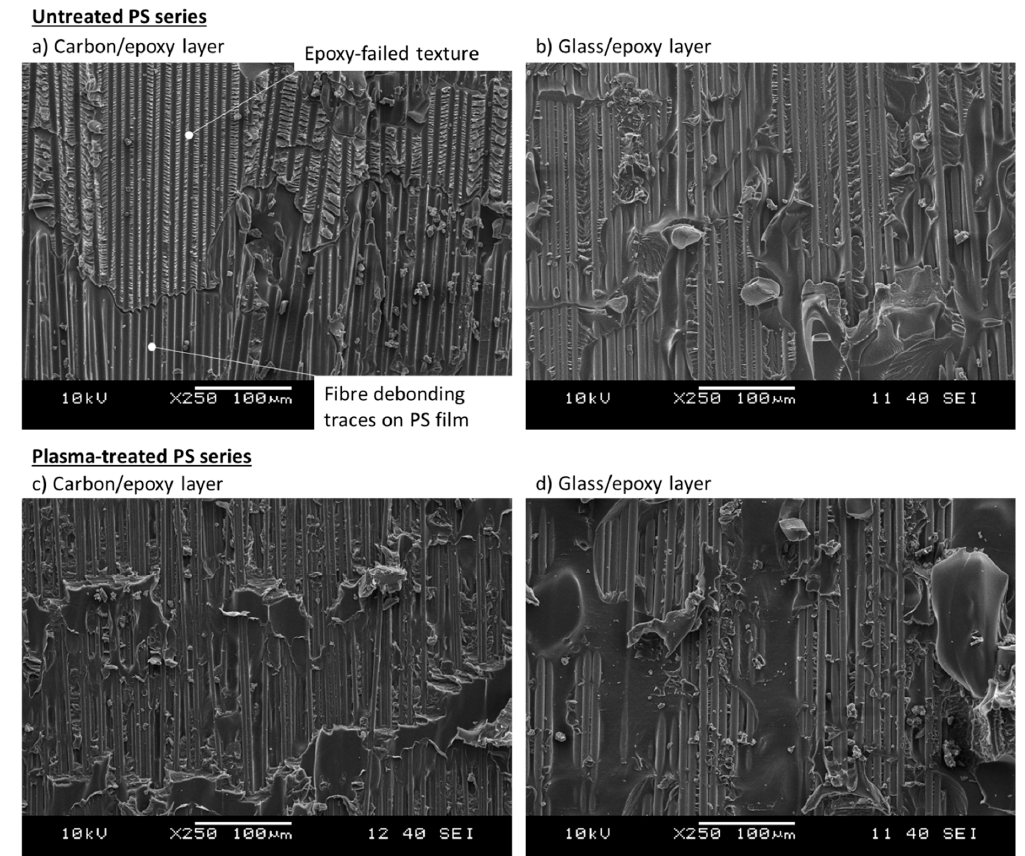
Figure 13. Delaminated surfaces of typical samples from the PS (( a ), ( b )) and plasma-PS (( c ), ( d )) series analysed with SEM.